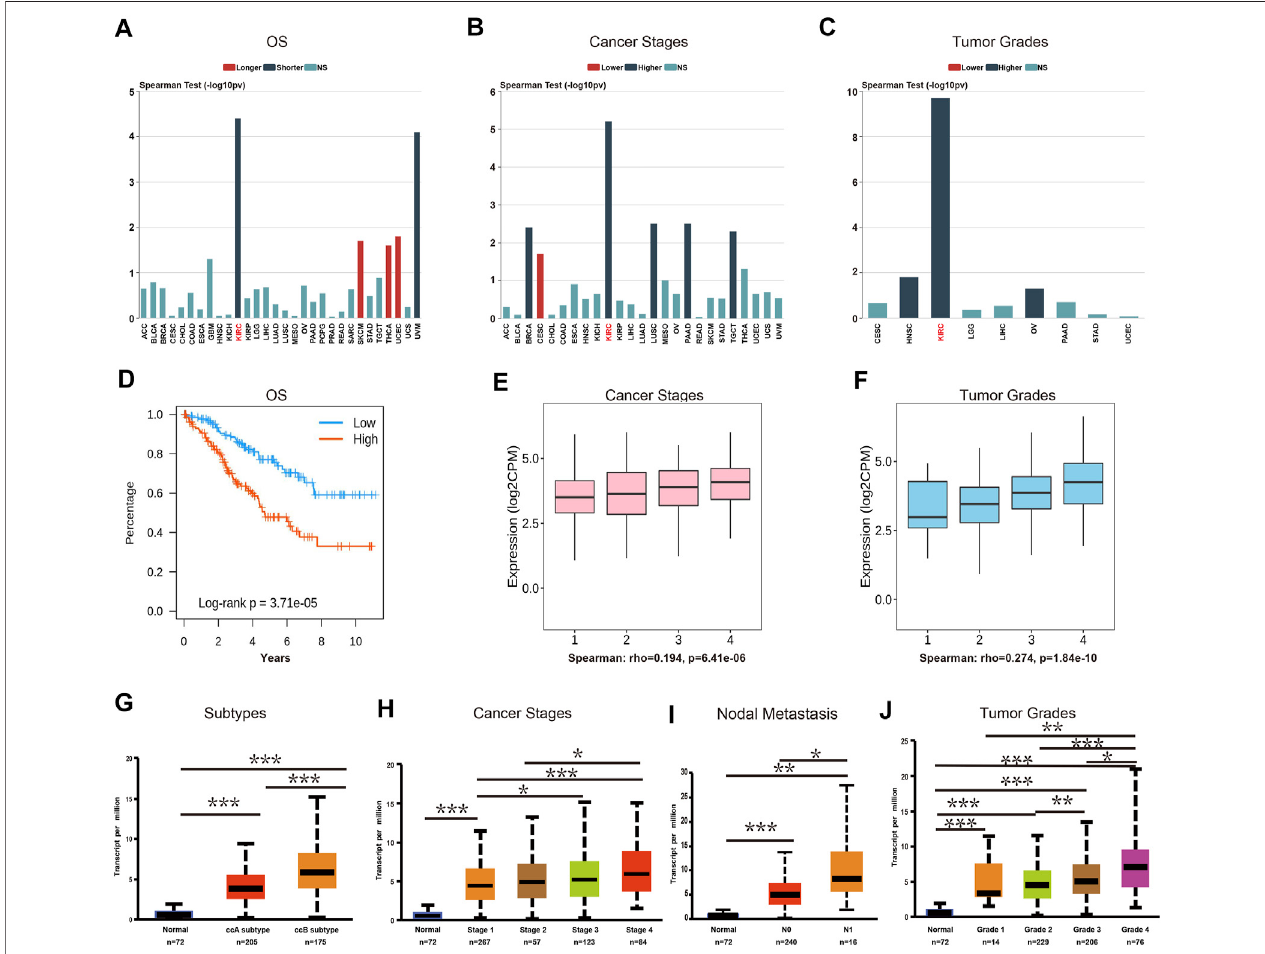
FIGURE 3 | The expression level of TRPM2 was correlated with subtype, cancer stage, nodal metastasis, and tumor grade in kidney renal clear cell carcinoma (KIRC). (A – C) CorrelationbetweenthemRNAlevelof TRPM2 andpatients ’ overall survival(OS) (A) , cancerstage (B) ,and cancergrade (C) inmultiple cancersusing the TISIDBdatabase. (D – F) Associations between the expression level of TRPM2and OS (D) , stage (E) , and grade (F) ofKIRC. (G – J) UALCAN analysis oftheassociations between TRPM2 expression and subtype (G) , cancer stage (H) , nodal metastasis (I) , and tumor grade (J) in KIRC. Data in (A – F) were derived from the TISIDB database (an integrated repository portal for tumor – immune system interactions). Data in (G – J) were analyzed using the UALCAN database. N0 , metastases in one to three axillary lymph nodes; N1 , metastases in one to three axillary lymph nodes. * p < 0.05, ** p < 0.01, *** p < 0.001.